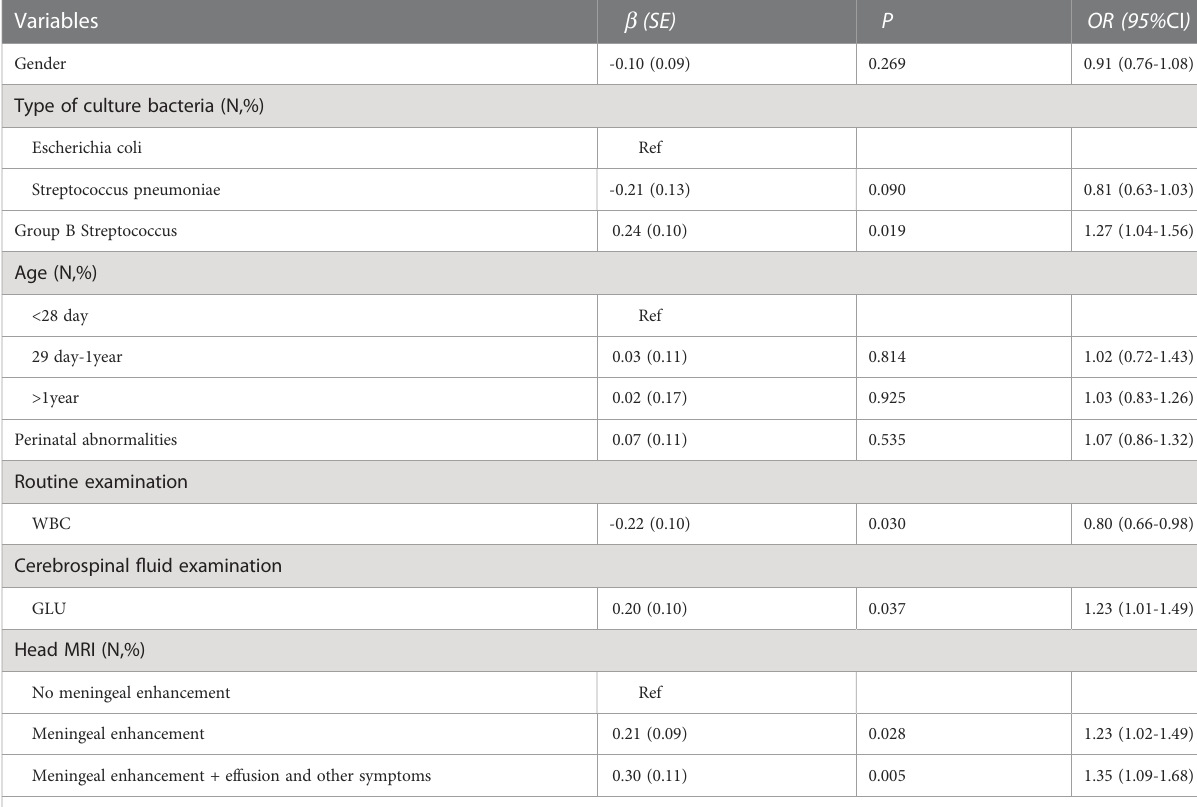
TABLE 5 Multivariate analysis of risk factors for length of hospitalization in children with